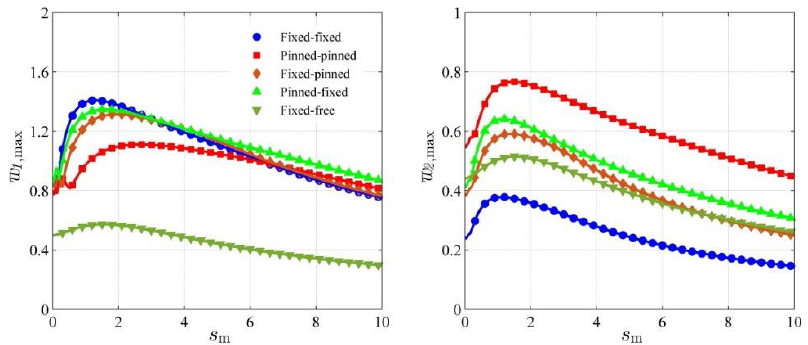
Figure 16. Maximum displacement ratios 𝑤̅ 1,max and 𝑤̅ 2,max versus mass ratio 𝑠 m for different boundary